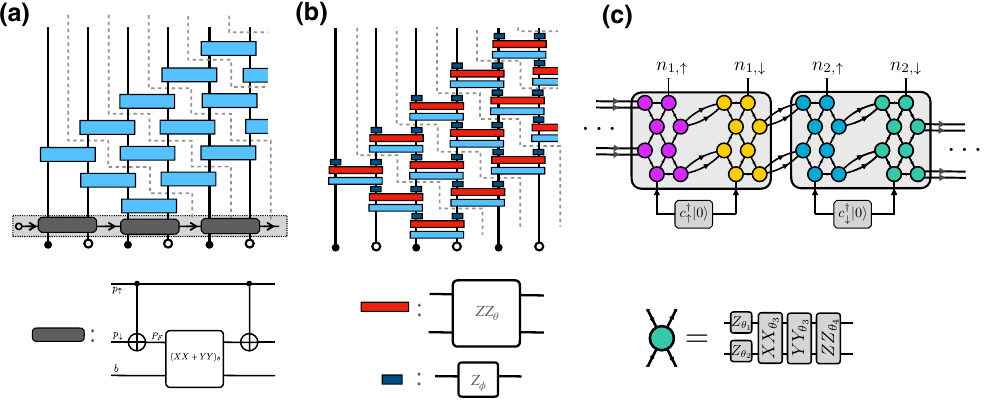
FIG. 2. Variational circuit architectures for correlated electron problems—the GMPS+X approaches augment the GMPS circuit preparing the Hartree-Fock ground state with non-Gaussian gates that build in correlations either by (a) GMPS+J: introducing an extra QMPS layer with an extra bond qubit (gray dashed box) or by (b) GMPS+U: generalizing the GMPS gates (blue boxes) to include non-Gaussian operations, ZZ θ = e − i 2 θ Z ⊗ Z and Z φ = e − i 2 φ Z . Here we draw the GMPS+X circuits only for block size B = 3 (the implemented circuits have twice this block size, B = 6 to include spin). (c) A problem-agnostic brick QMPS ansatz consisting of a brickwork of general number-conserving two-qubit gates. Here, for any Hermitian operator O , O θ denotes a gate corresponding to unitary u [ O θ ] = e − i θ O / 2